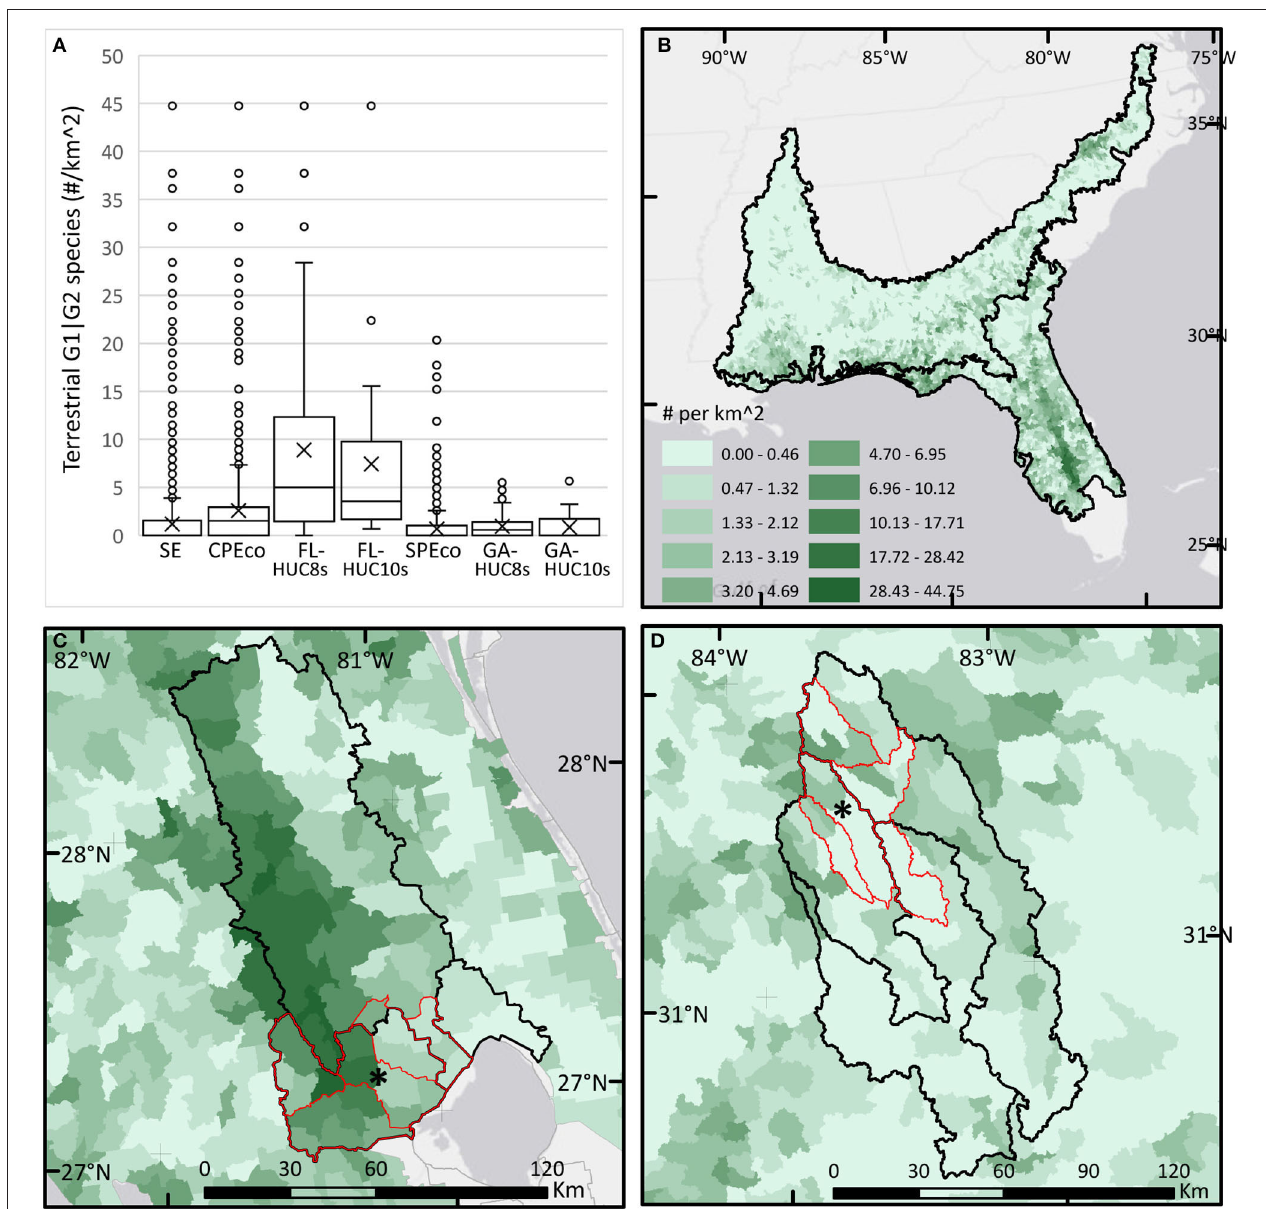
FIGURE 8 | Boxplots and maps of numbers of rare and imperiled terrestrial species (G1|G2) calculated for each HUC-12 (n /100 km 2 ) and summarized for each study area (clockwise from top left). Asterisk (*) shows location of LTAR sites. (A) Boxplots of terrestrial G1|G2 species for each study area. (B) Map of terrestrial G1|G2 species calculated for HUC-12s in the Southeast (SE). (C) Map of terrestrial G1|G2 species calculated for HUC-12s in the Florida study areas. (D) Map of terrestrial G1|G2 species calculated for HUC-12s in the Georgia study